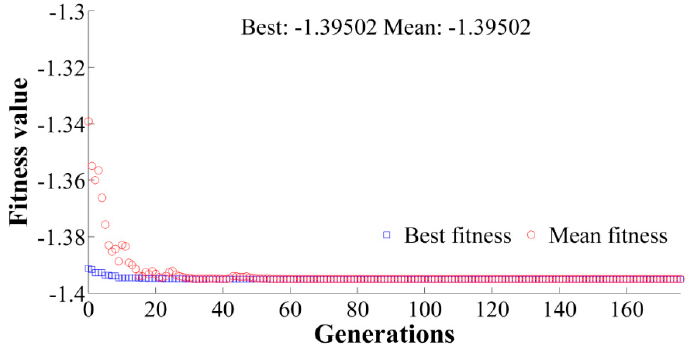
Figure 6. Variation of fractal dimension (fitness values) with generations.